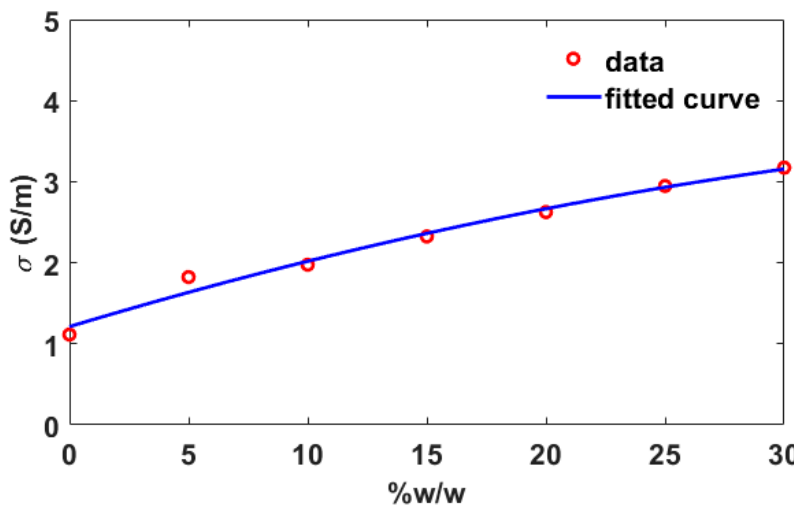
Figure 15. The curve fitting of the electrical conductivity at the frequency of 3.74 GHz.